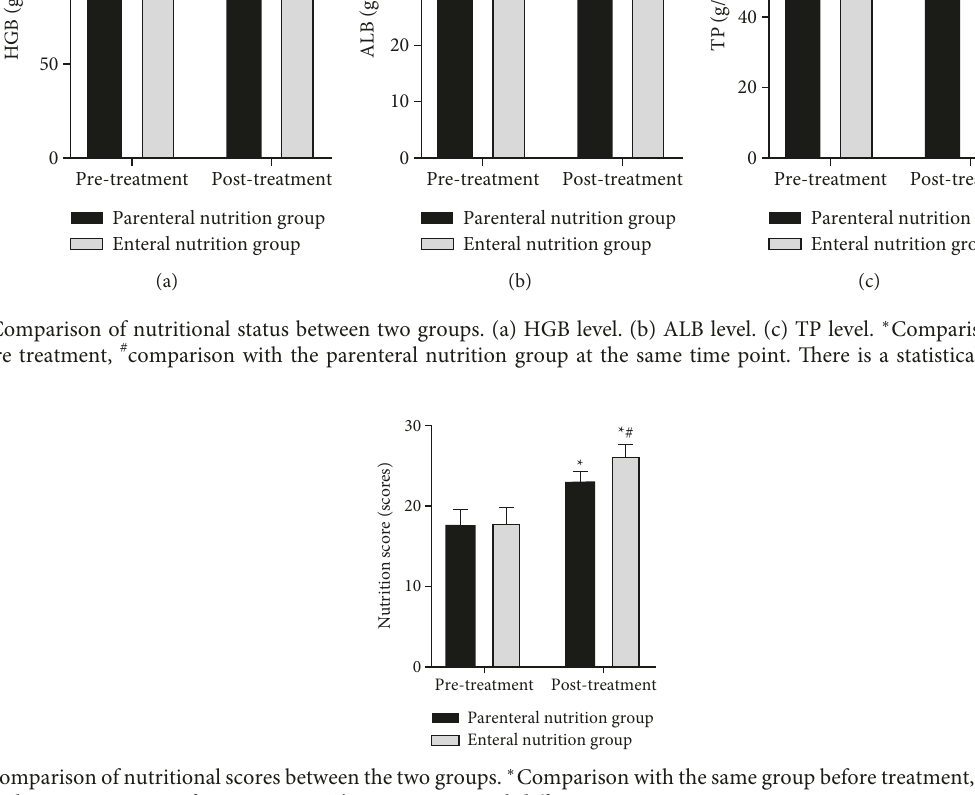
Comparison with the same group before treatment, # comparison with ∗